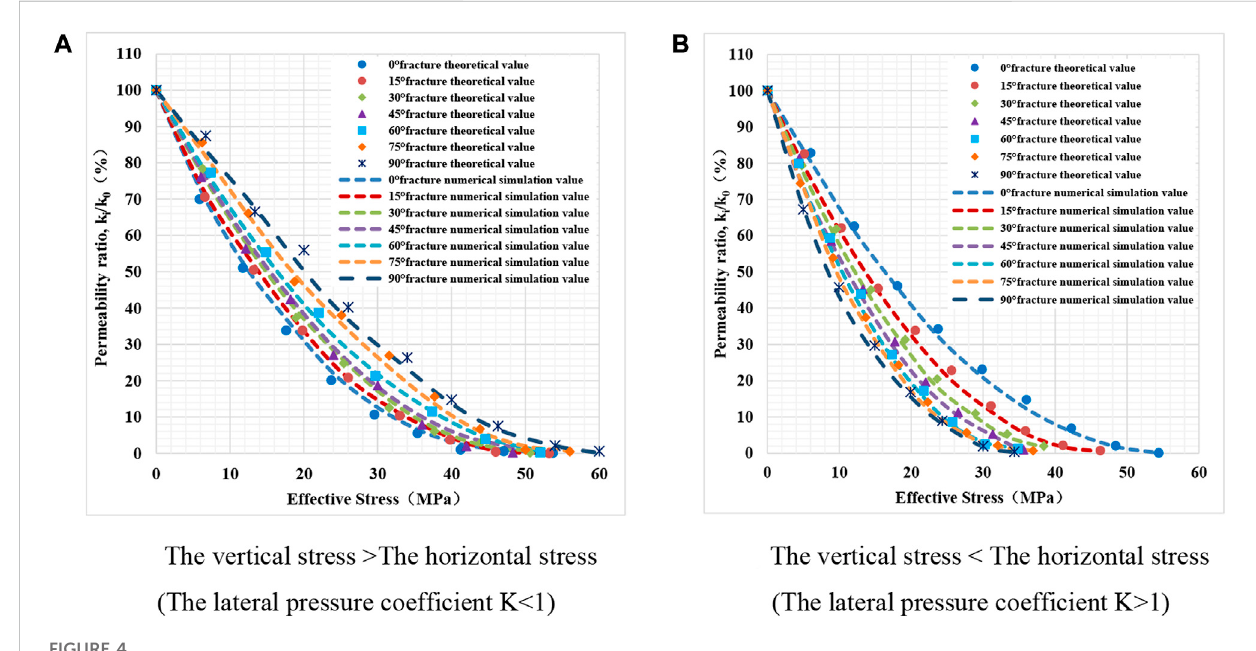
Variation curve of permeability ratio of fractures at different angles with effective stress.